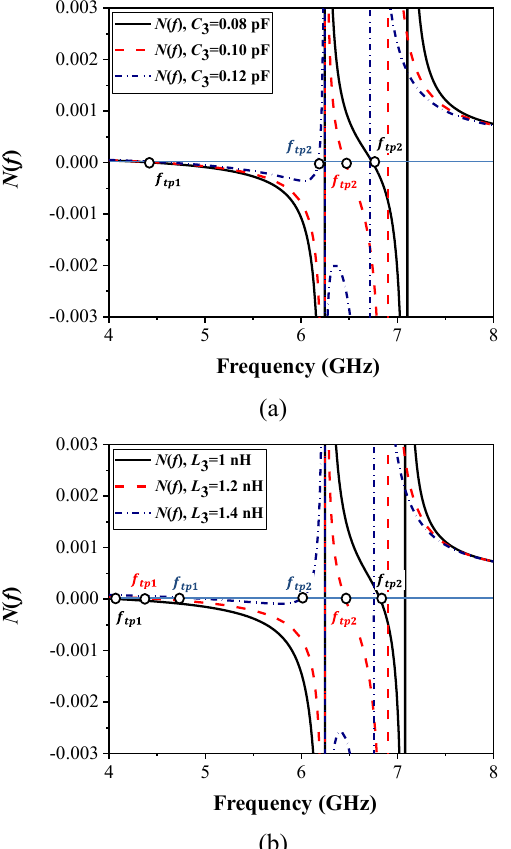
Figure 5: Relations between the N ( f ) and transmission poles for the proposed LUC ( L 1 =0.9 nH, C 1 =0.1 pF, L 2 =0.4 nH and C 2 =0.4 pF are fixed) under different values of (a) C 3 (with L 3 =1.2 nH) and (b) L 3 (with C 3 =0.1